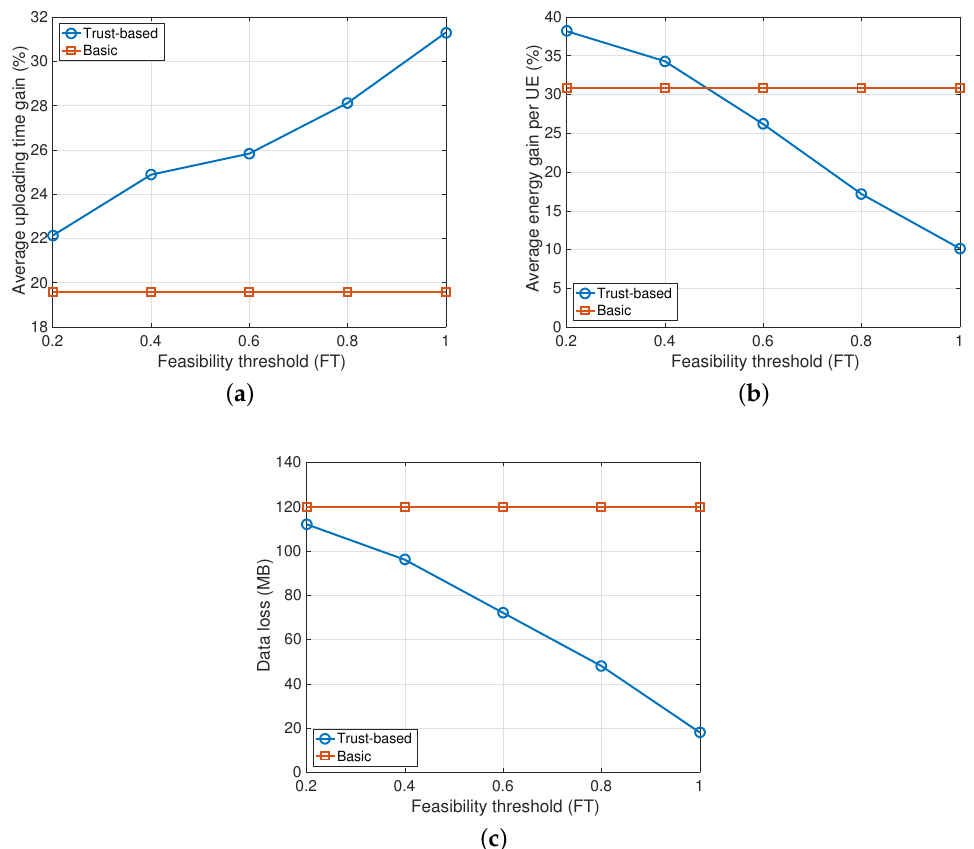
Figure 4. Impact of feasibility threshold (50% of malicious nodes, half of type A and half of type B). ( a ) Uploading time gain; ( b ) Average energy gain; ( c ) Data loss. UE: user